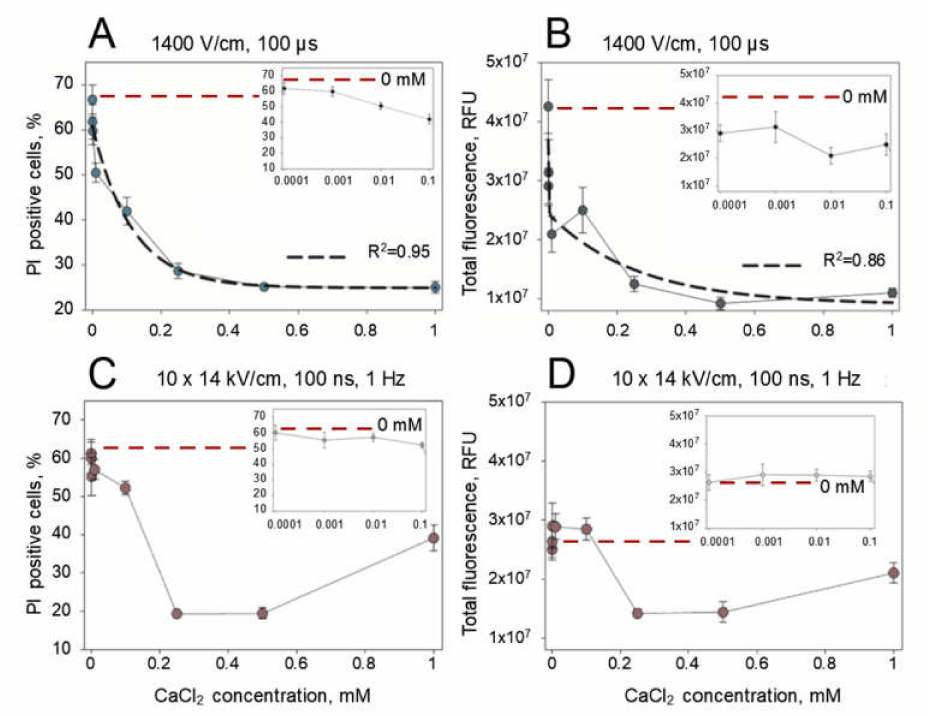
Figure 4. Dependence of PI electrotransfer e ffi ciency ( A,B ) and the total cell fluorescence ( C,D ) after treatment with 1 × 1400 V / cm strength and a 100- µ s duration electric pulse ( A,C ) or 10 × 1.4 kV / cm strengthand a 200-nselectric pulsesat 1 Hzof repetitionfrequency ( B,D ) atvarious CaCl 2 concentrations; the results are represented in linear scale. The inserts in each figure represent the corresponding results in the range of low 0.0001–0.1 mM CaCl 2 concentrations on the logarithmic scale. PI fluorescence was measured 15 min after electric field application. The error bars represent the mean ± standard error of mean of n = 6 experimental